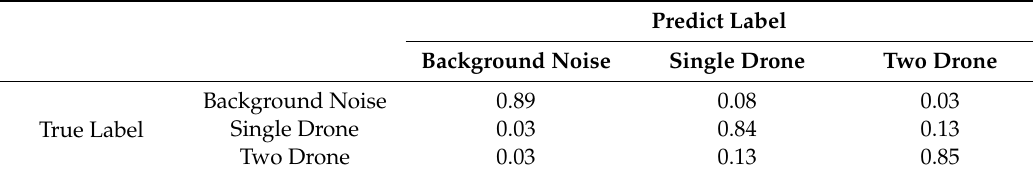
Table 5. The confusion matrix from CoNN with MFCC classes.